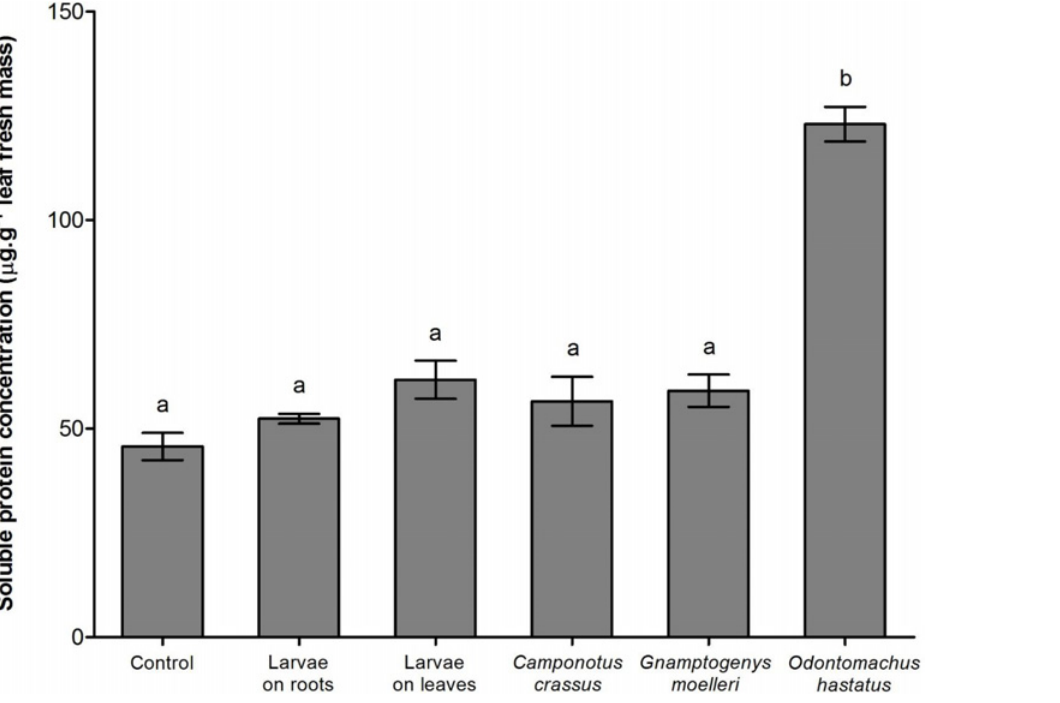
Fig 2. Soluble protein concentration of bromeliads. Soluble protein concentration for Quesnelia arvensis leaves of different treatments (control; Tenebrio larvae among roots; Tenebrio on leaves; Camponotus crassus ants and Tenebrio ; Gnamptogenys moelleri and Tenebrio ; and Odontomachus hastatus and Tenebrio ). Bars indicate the standard error and letters indicate Tukey post-hoc test ( α < 0.05).